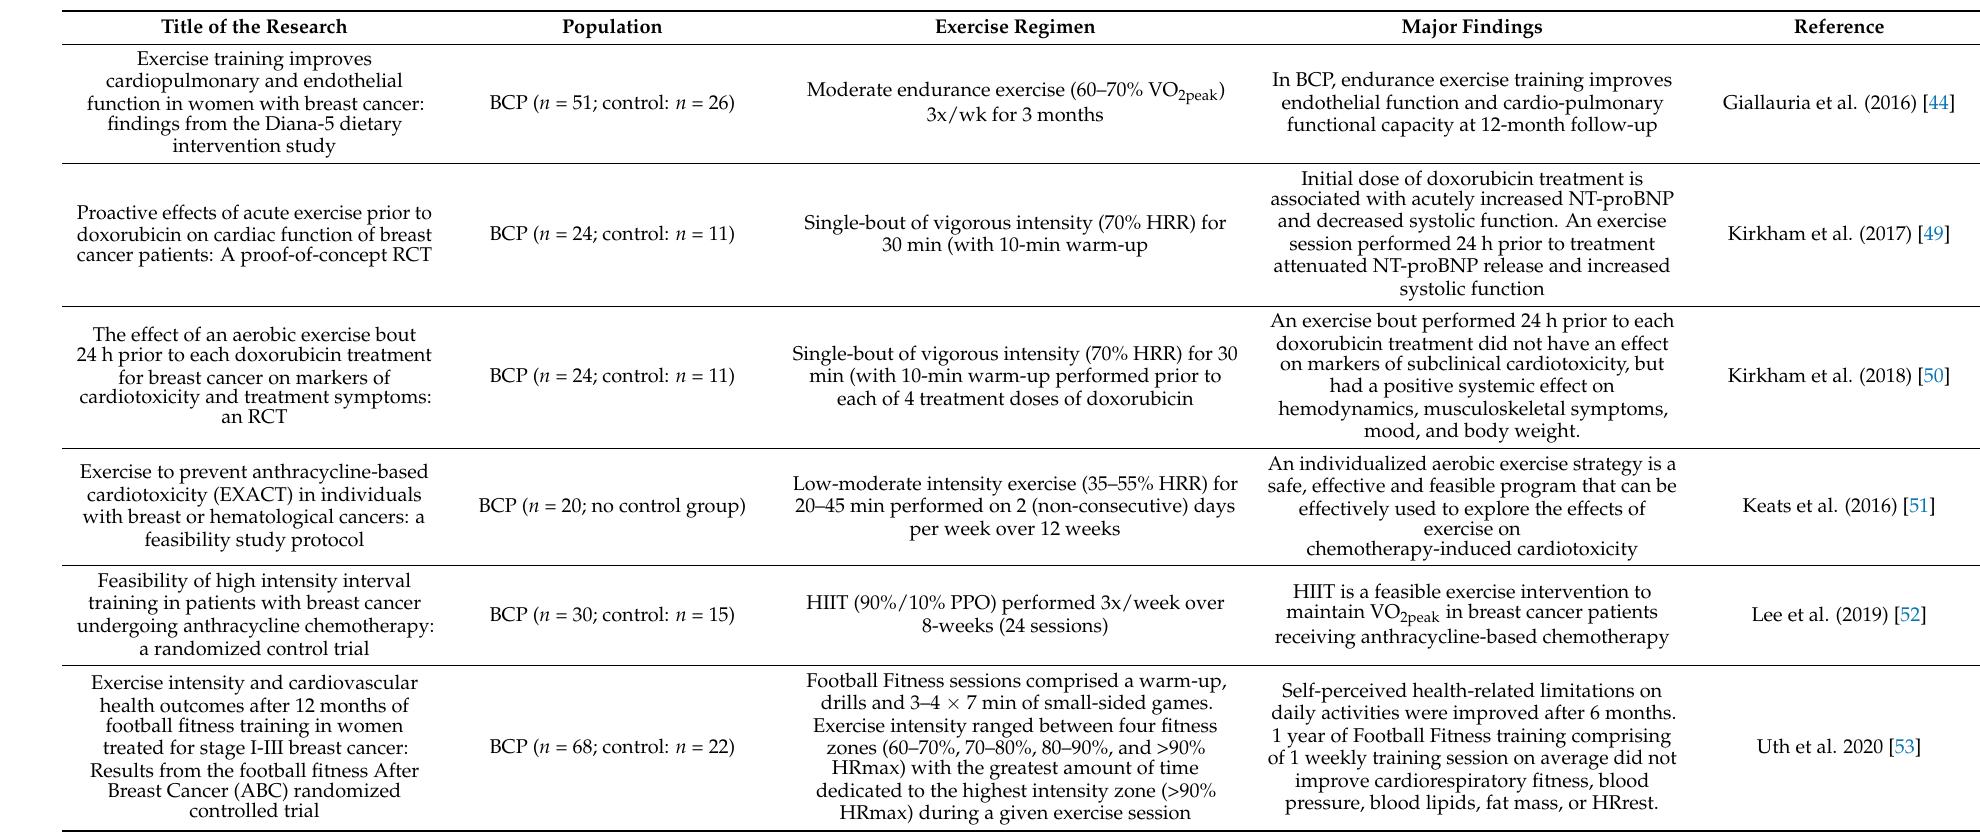
Table 3. Aerobic Exercise Clinical Trials in Breast Cancer